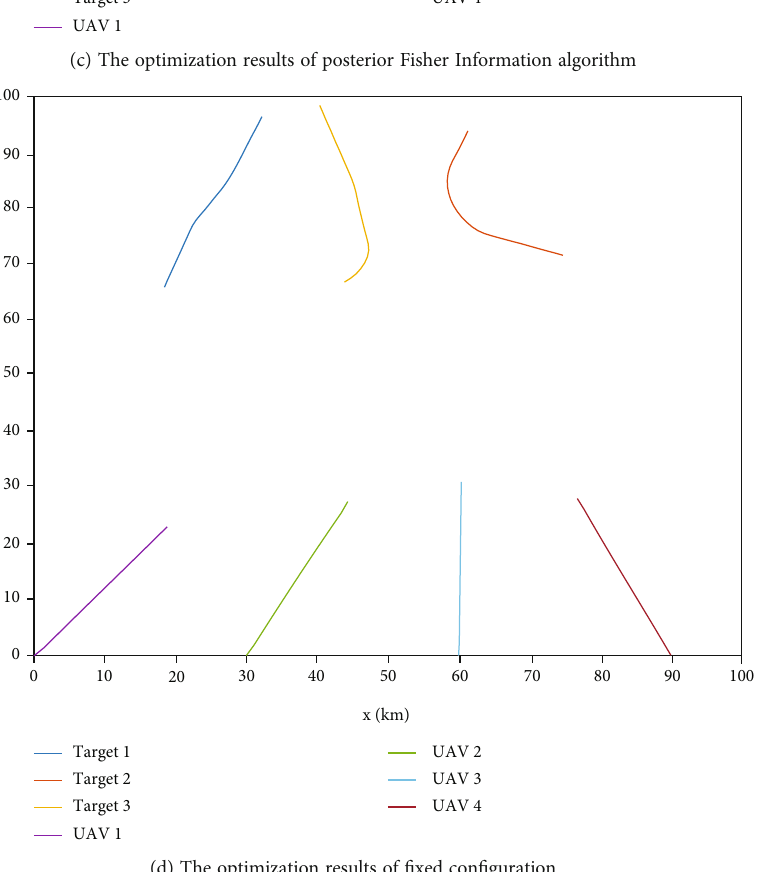
Figure 6: Comparison of the results of di ff erent optimization